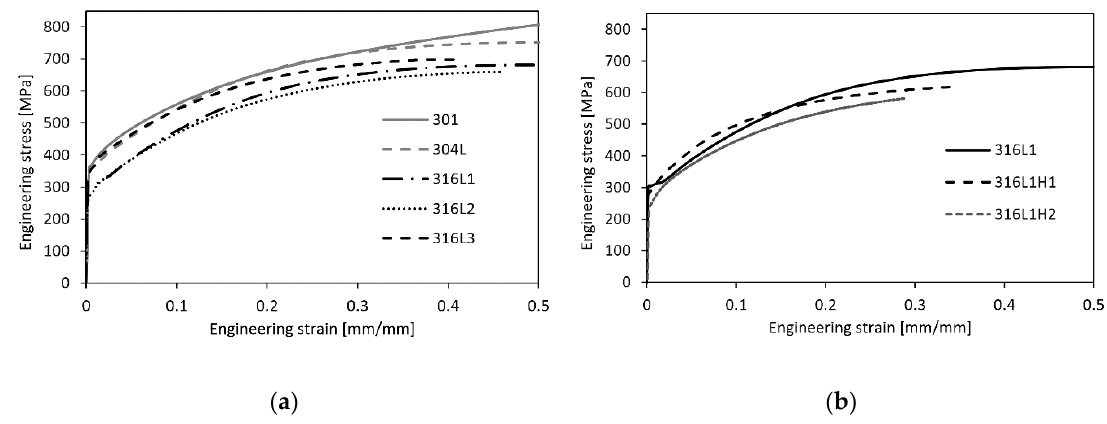
Figure 9. Engineering stress strain curves for tensile samples tested in RD for ( a ) Commercial stainless steel alloys; ( b ) Heat treated 316L1 alloys.